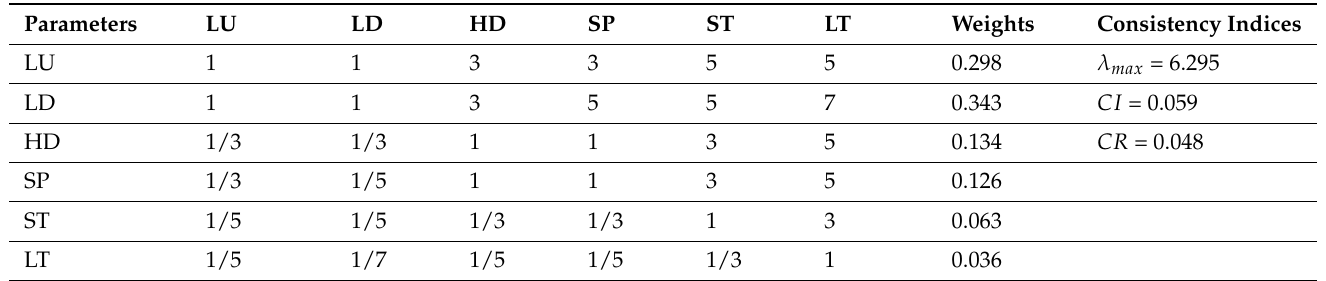
Table 7. Comparison matrix and factors